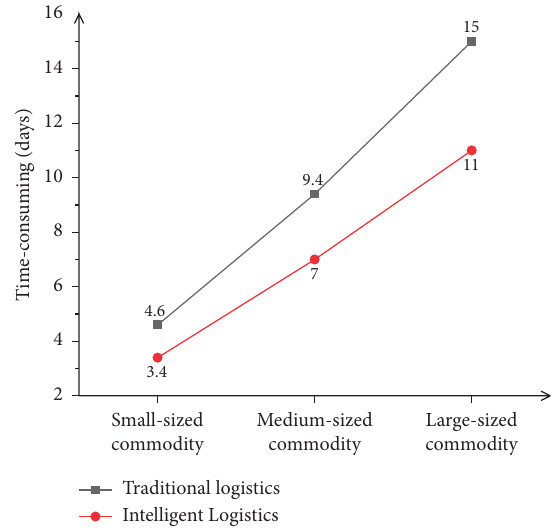
Figure 17: Comparison of the distribution